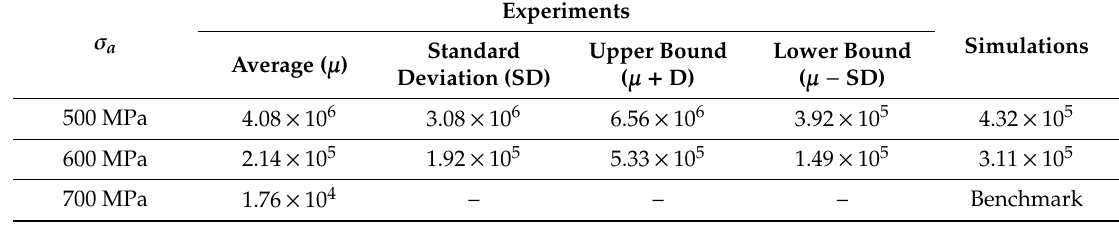
Table 3. Comparing fatigue crack initiation life estimation with experimental data.